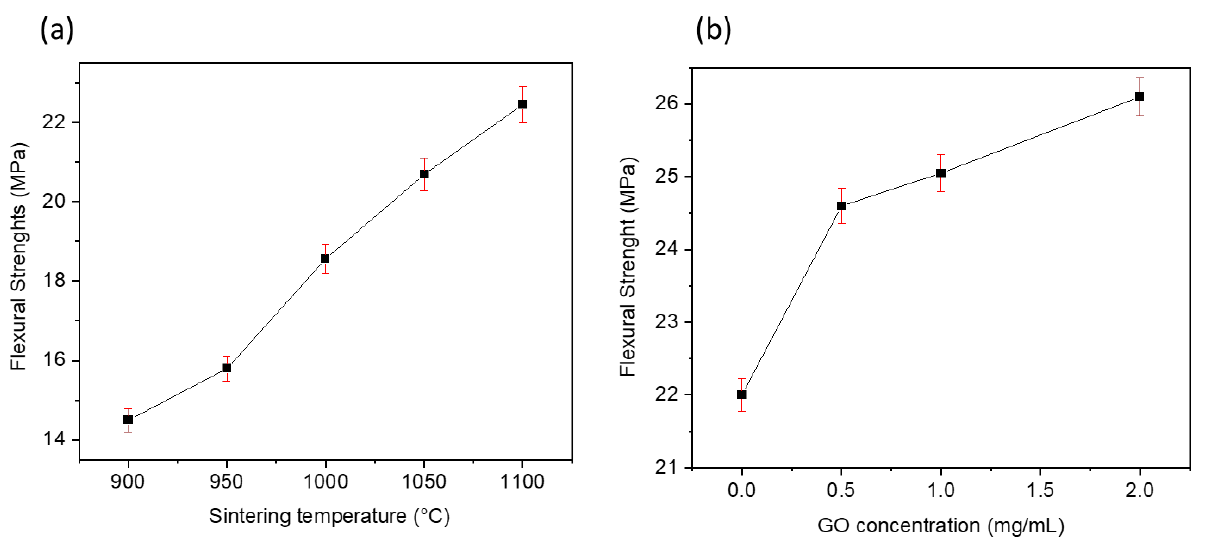
Figure 6. ( a ) Effect of calcination on the flexural strength of the phosphate ceramic support; ( b ) effect of the GO concentration on the flexural strength of the GO/ceramic membrane.